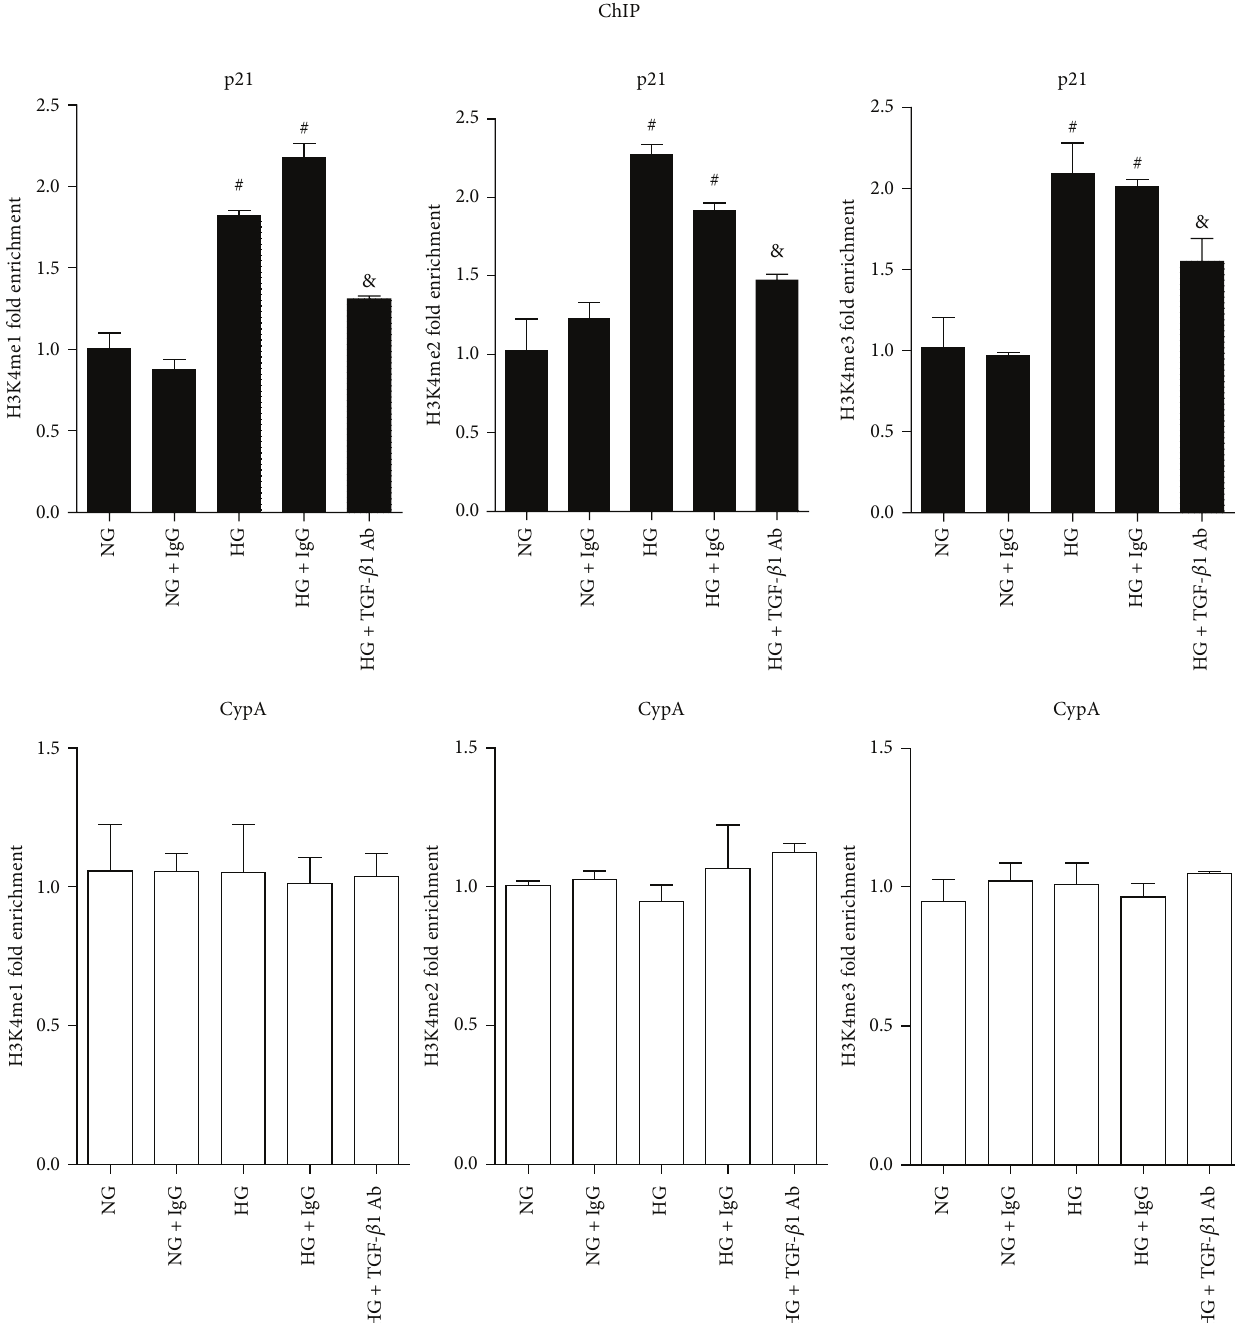
Figure 5: TGF- 𝛽 1-specific antibody reversed HG-induced H3K4me1/2/3 levels at p21 gene promoter in RMCs. Bar graphs showing H3K4me1, H3K4me2, and H3K4me3 levels at p21 and CypA gene promoters in RMCs. Serum-depleted RMCs were treated as described in Materials and Methods. ChIP assays were performed as described in Materials and Methods. Results were expressed as fold over NG (mean ± SEM; # 𝑃 < 0.05 compared to NG; & 𝑃 < 0.05 compared to HG, 𝑛 = 3 ).